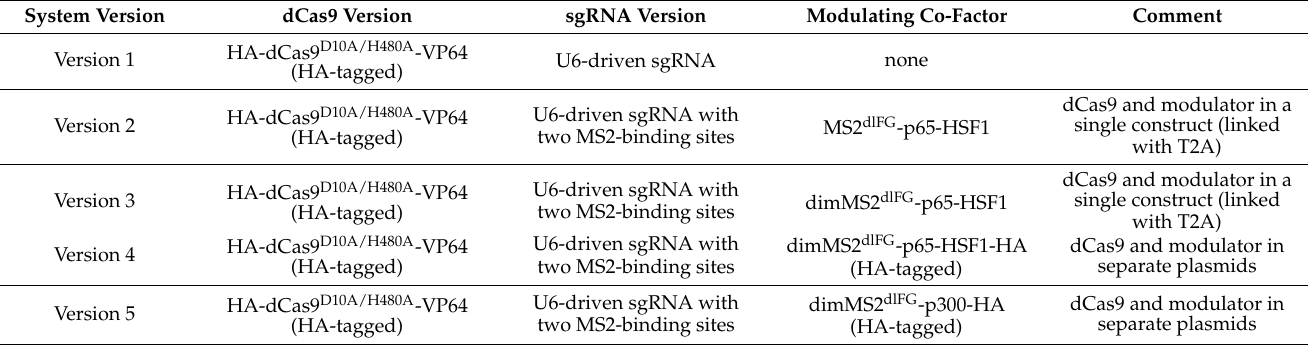
Table 1. Overview of versions of transcription activation systems used in the